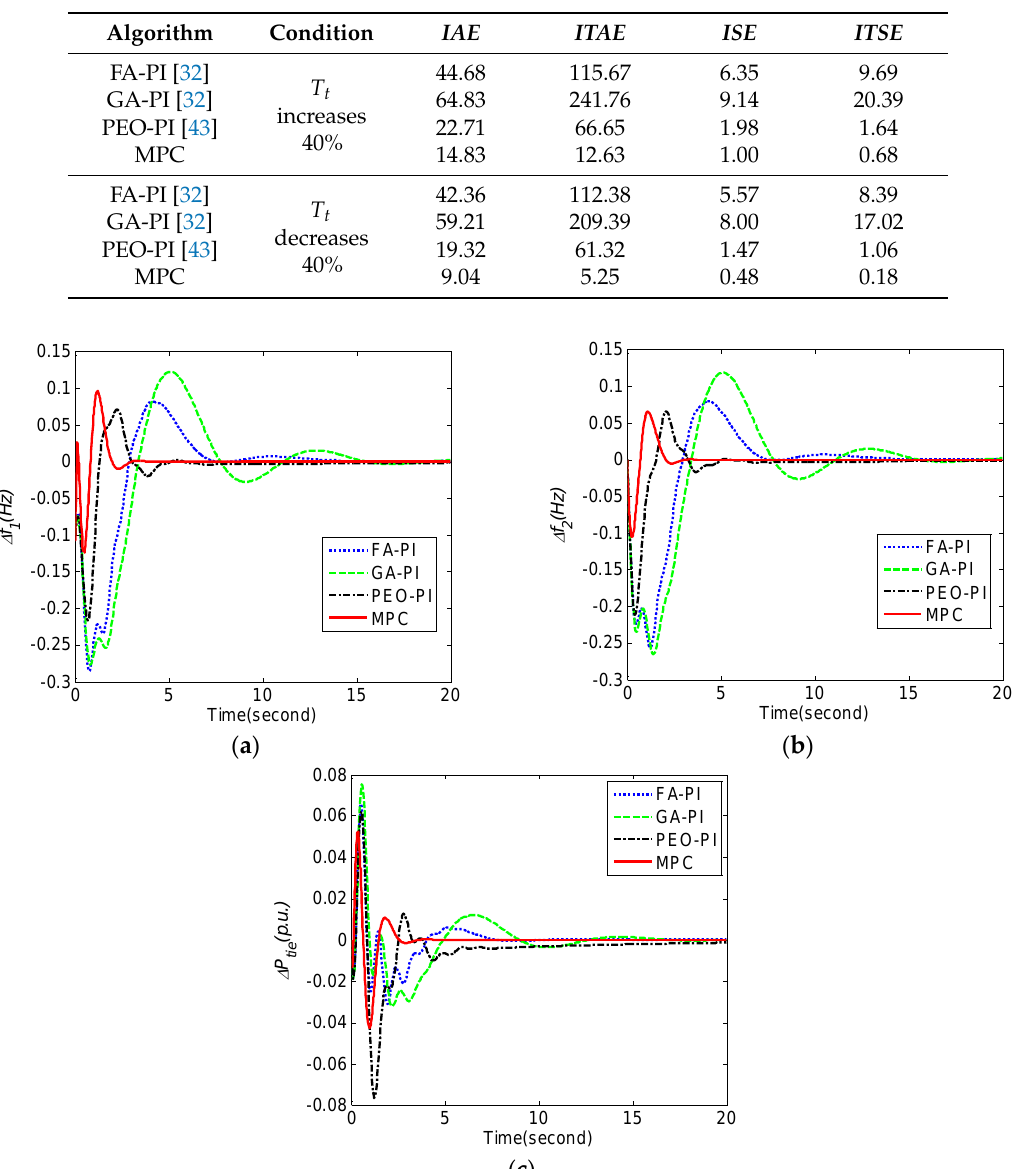
Table 7. Performance comparison of MPC, PEO-PI, GA-PI and FA-PI for case 4.